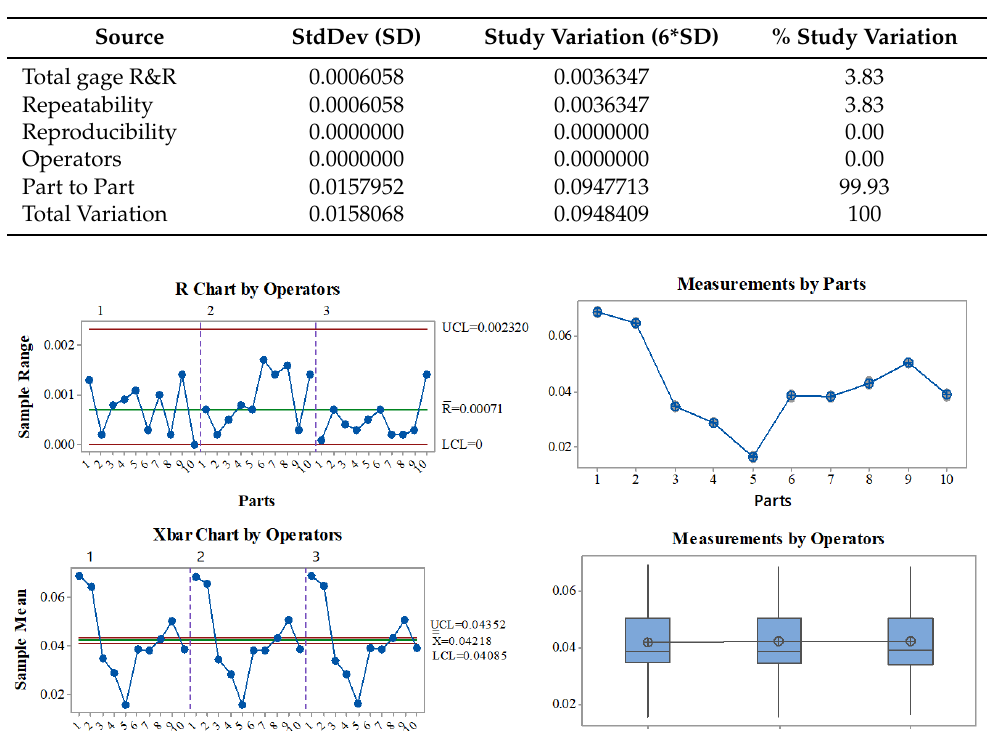
Table 3. Gage R&R variation contribution.